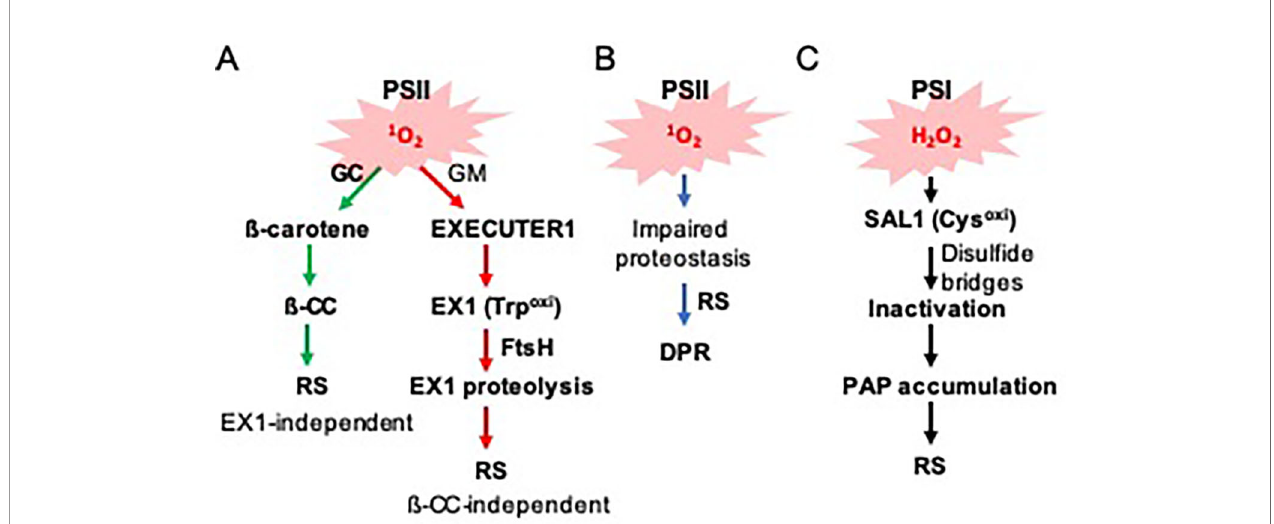
FIGURE 1 | Photosystems-driven ROS trigger distinct RS pathways. (A) PSII-associated 1 O 2 sensors beta-carotene and EX1 mediate RS in the grana core (GC) and grana margins (GMs), respectively. 1 O 2 oxidizes ß-carotene and EX1, resulting in the generation of ß-CC and EX1(Trp643 oxi ). While ß-CC serves as a volatile RS molecule, it is unclear how EX1(Trp643 oxi ) degradation alters the expression of 1 O 2 -responsive nuclear genes. (B) 1 O 2 constantly damages PSII core proteins, which leads to the accumulation of damaged proteins in the chloroplasts of the var2 mutant. The impaired proteostasis triggers a DPR via an EX1-independent pathway. (C) PSI-driven ROS (such as H 2 O 2 ) inactivate the SAL1 enzyme via intra- and/or inter-disul fi de bond formation, leading to the accumulation of its substrate PAP. PAP then mediates